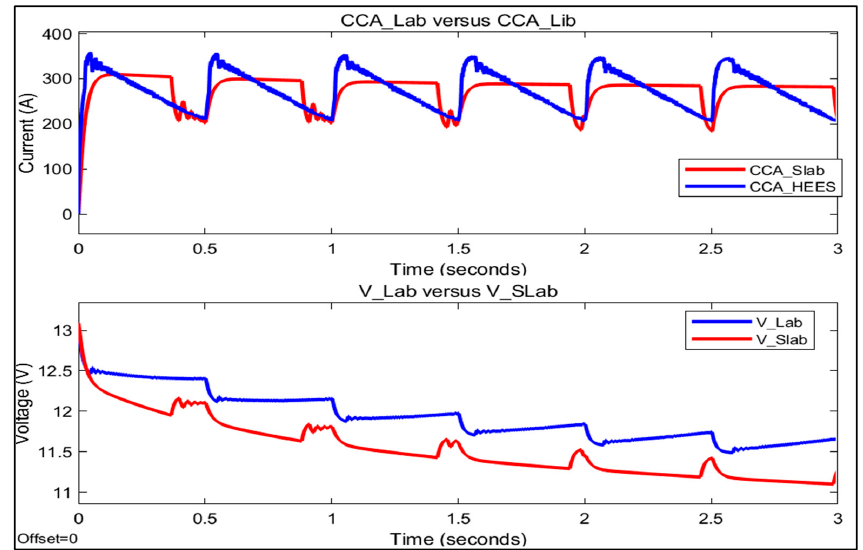
Figure 20. The delivered HESS CCC versus SLAB and voltage response of LAB versus SLAB during discharging mode for cases one and two.